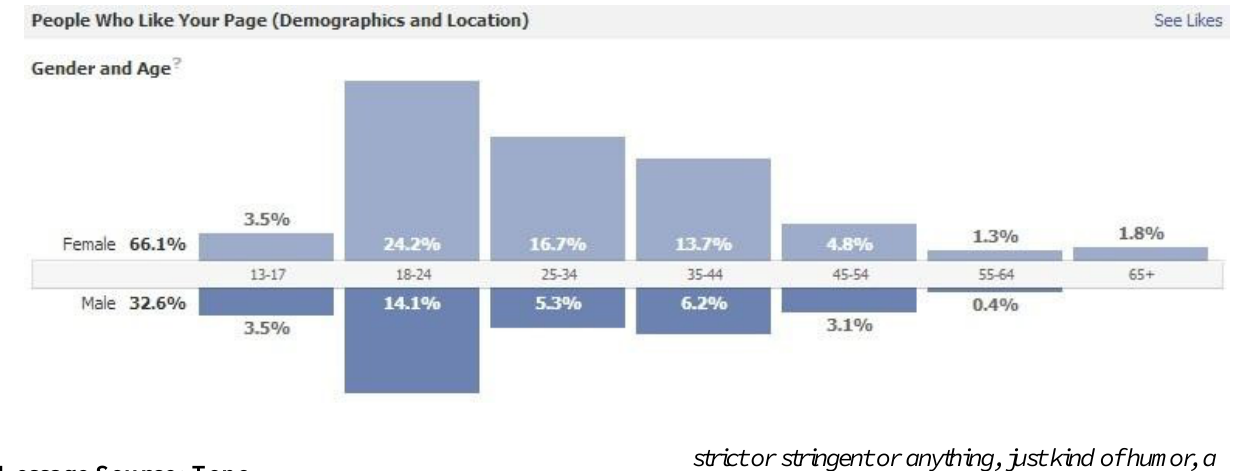
Figure 6. Age distribution of Facebook Likes on the Keep It Strong ATL corporate website, generated in Facebook Insights (n=223).